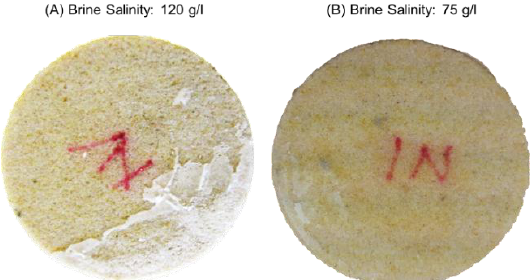
Figure 4. Pictures showing salt cake development at the core inlet when brine salinity was decreased from ( a ) 120 g/L to ( b ) 75 g/L. Decrease in brine salinity further decreased the amount of deposited salts.